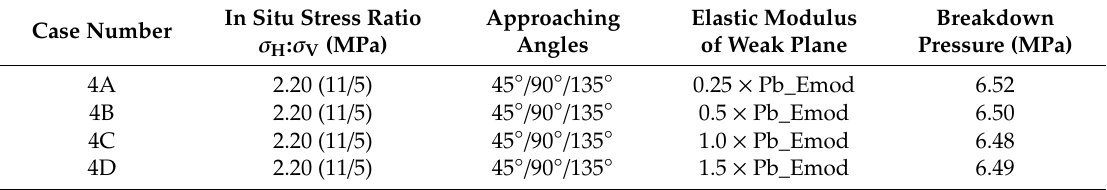
Table 8. Experimental scheme of Group 4 and results of breakdown